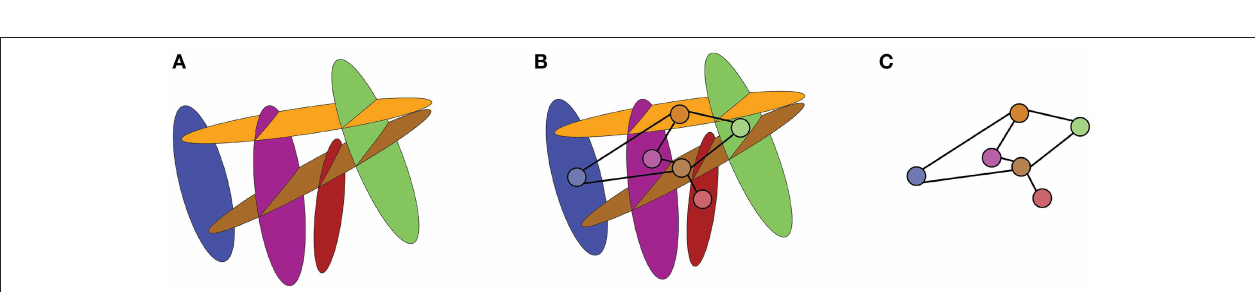
FIGURE 1 | (A) Representation of a two-dimensional fracture network. (B) Equivalent graph placed on top of fracture network. (C) Equivalent graph representation of (A) . (Figure from Andresen et al. [7].)